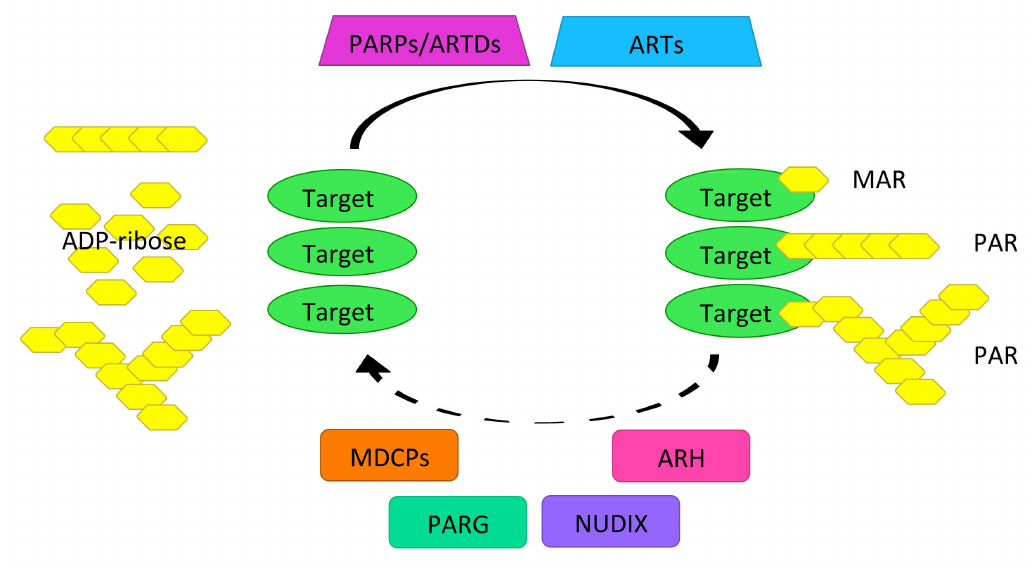
Figure 1. Homeostasis of ADP-ribosylation. ADP-ribosylation is up-regulated by poly- ADP-ribose polymerases/Diphtheria toxin-like ADP-ribosyltransferases (PARPs/ARTDs) and ADP-ribose transferases (ARTs), adding one or more ADP-ribose from NAD to target proteins, and down-regulated by another group of enzymes poly-ADP-ribose glycohydrolase (PARG), ADP-ribosyl hydrolase (ARH), nucleoside diphosphate linked to another moiety X (NUDIX), and macrodomain-containing proteins (MDCPs), degrading and removing poly-ADP-ribose (PAR) or mono-ADP-ribose (MAR) chains. The ADP- ribosylation modifying enzymes function jointly to coordinate the metabolic turnover and recycling of